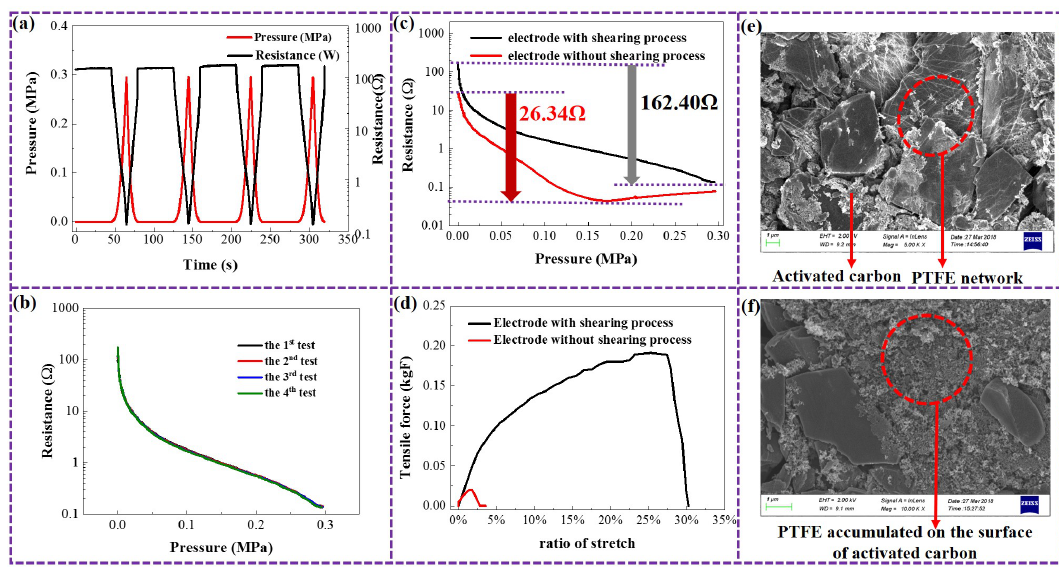
Figure 3. Changes in the microstructure and macroscopic properties of the porous electrodes by a shearing process. ( a ) Resistance change of the electrode during four consecutive pressurization– depressurization processes. ( b ) Repeatability of electrode piezoresistive characteristics during four consecutive pressurization–depressurization processes. ( c ) Piezoresistive characteristics of the electrodes with and without the shearing process. ( d ) Elasticity of the electrodes with and without the shearing process. ( e ) Electron micrograph of the electrodes with the shearing process where PTFE is the abbreviation of polytetrafluoroethylene. ( f ) Electron micrograph of the electrodes without the shearing